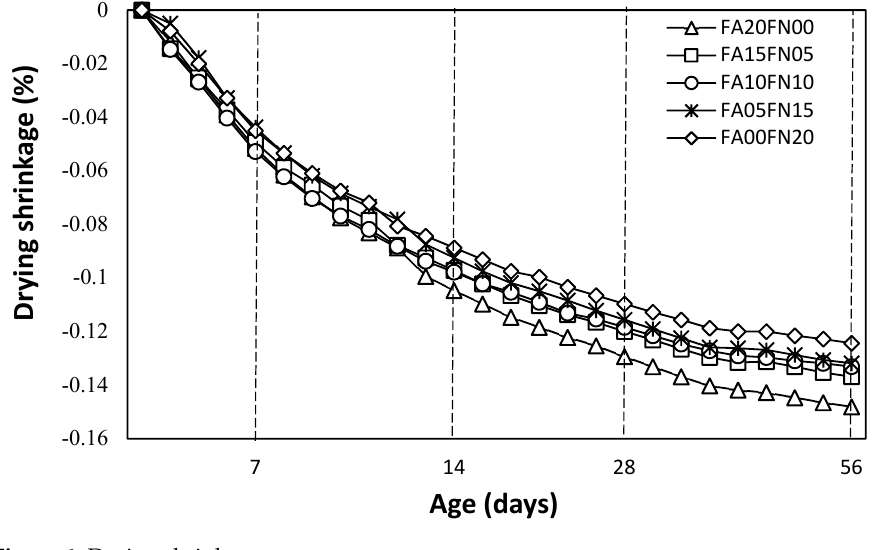
Figure 6. Drying shrinkage.